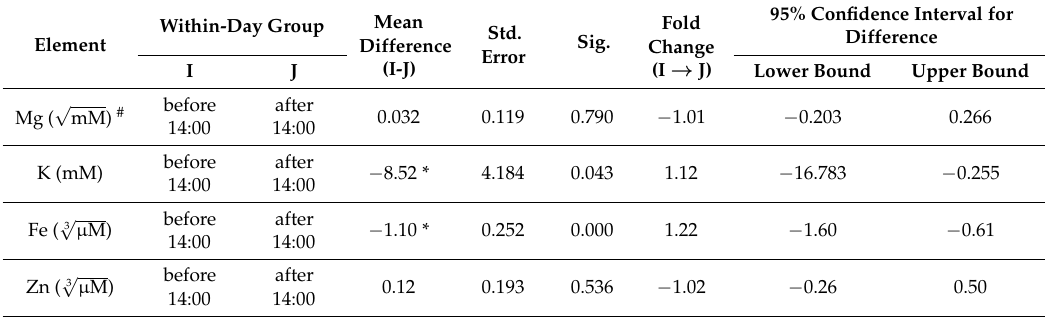
Table 1. Pairwise comparison of time of day groupings for each element, based on estimated marginal means from a two-way ANOVA using a Bonferroni adjustment for the comparison.